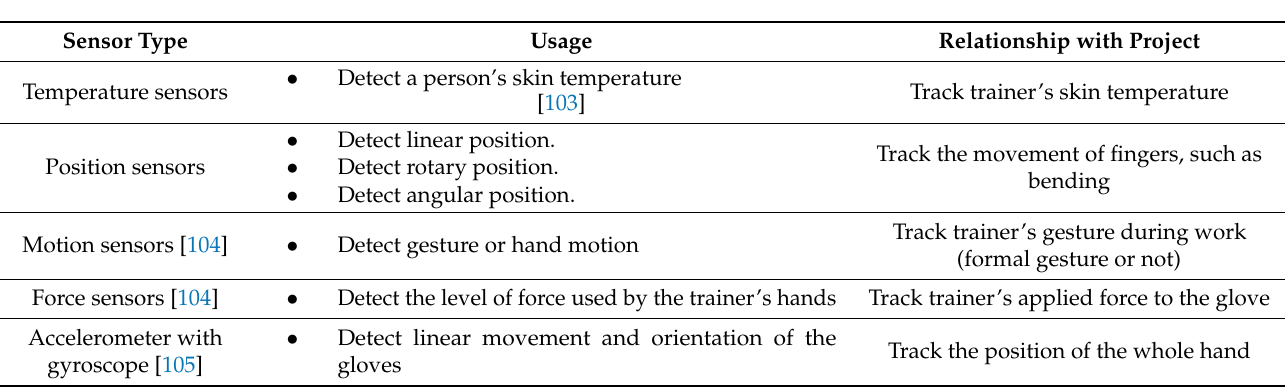
Table 2. Sensing device